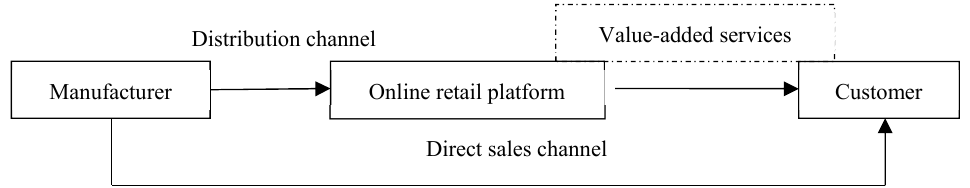
Figure 1. Value-added service model of online retail platform in the dual-channel supply chain.